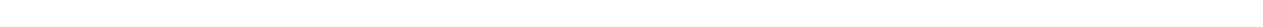
Fig. 1 Force transmission from followers facilitate leader cell formation. a Illustration depicting generation of con fi nement on a polyacrylamide (PAA) gel using polydimethylsiloxane (PDMS) blocks. Removal of con fi nement triggers collective cell migration. b Schematic representation of cell monolayer immediately after (T 0 h), three hours (T 3 h), and seven hours (T 7 h) after con fi nement removal. c From top to bottom, representative phase contrast images (Panel-1), corresponding traction force pro fi les (Panel-2), landscapes of average normal stress overlapped with phase contrast images (Panel-3) and corresponding color coded maps of shape indices (Panel-4) showing accumulation of high forces and local unjamming-like transition in followers behind future leaders in different phases of wound healing. d Scatter dot plot showing traction forces behind leader and non-leader cells in phase 0 and phase 1. e Scatter dot plot showing average normal stress behind leader and non-leader cells in phase 0 and phase 1. f Box plot showing shape indices in the regions behind leader and non-leader cells in phase 0 and phase 1. Box plots shows median and quartiles. L1 and L2 are leader cells appearing in Phase-1 and Phase-2, and are marked with orange dots. Red and blue circles mark the zones considered for statistical comparison of the traction stress behind leaders and non-leaders respectively and are de fi ned by force localization length (radius = L P /2). Whiskers are maximum and minimum data points. Line in scatter dot plots represent mean. * P < 0.05, **** P < 0.0001, Mann – Whitney test. S.D is standard deviation and C.V. is coef fi cient of variation. Scale bars = 100 μ m. Data collected from at least three independent